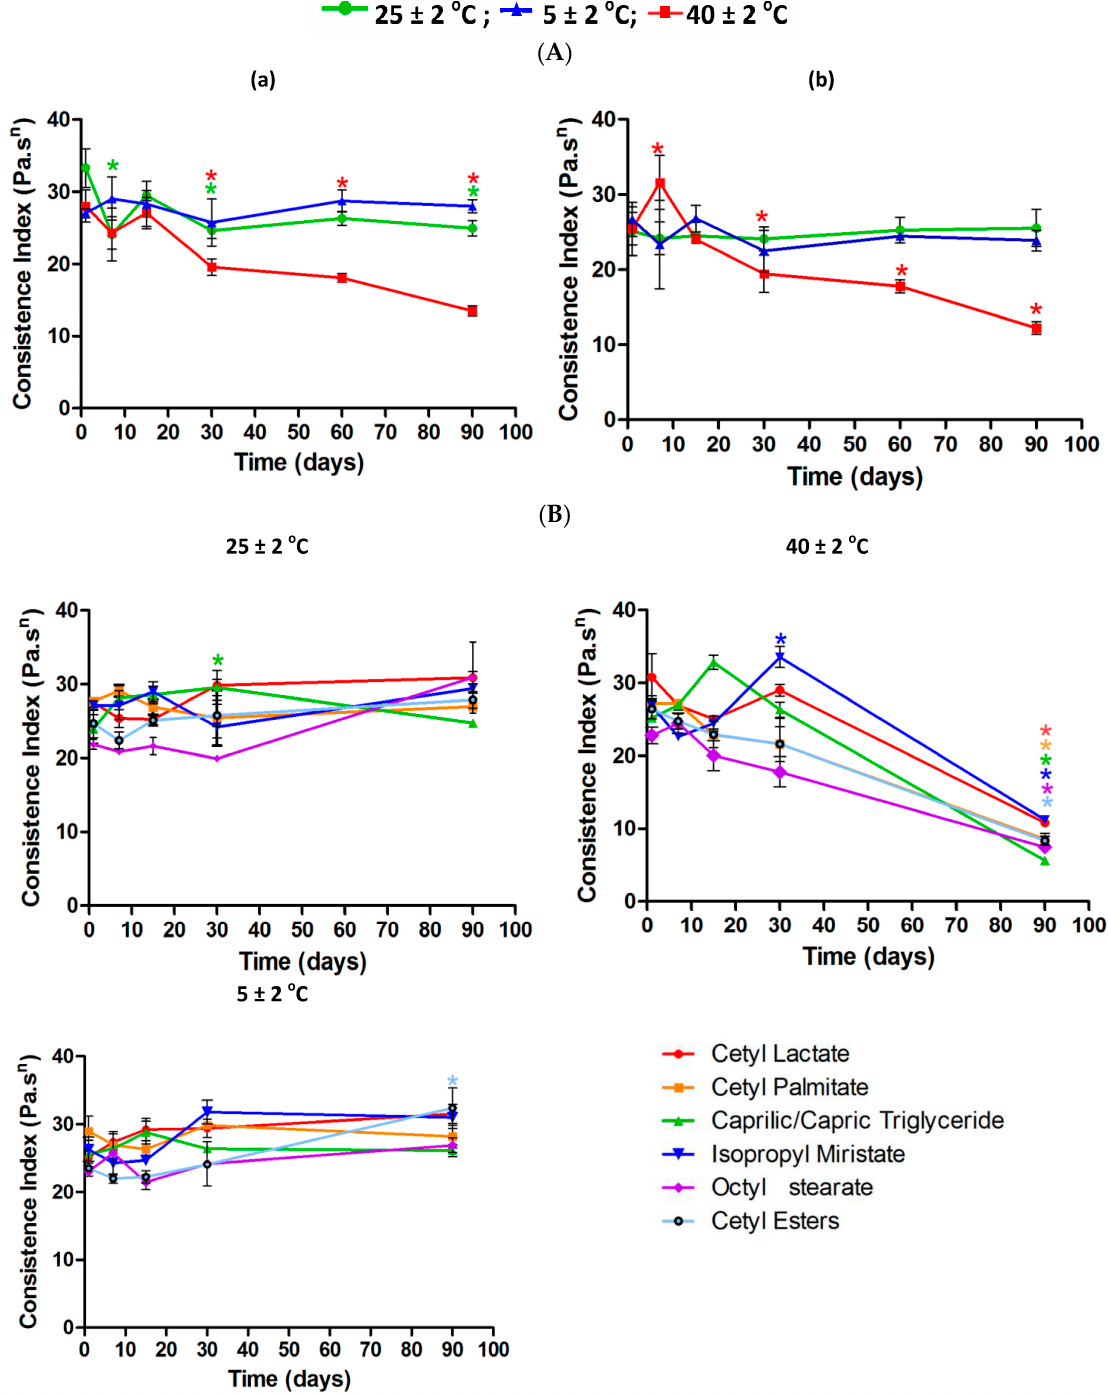
Figure 8. Consistency index for the 6.5 ( a ) and 7.0 ( b ) formulations during Prolonged Stability Test ( n = 3) without ( A ) or with ( B ) fatty esters. (* Statistically significant differences were 95%, p ă